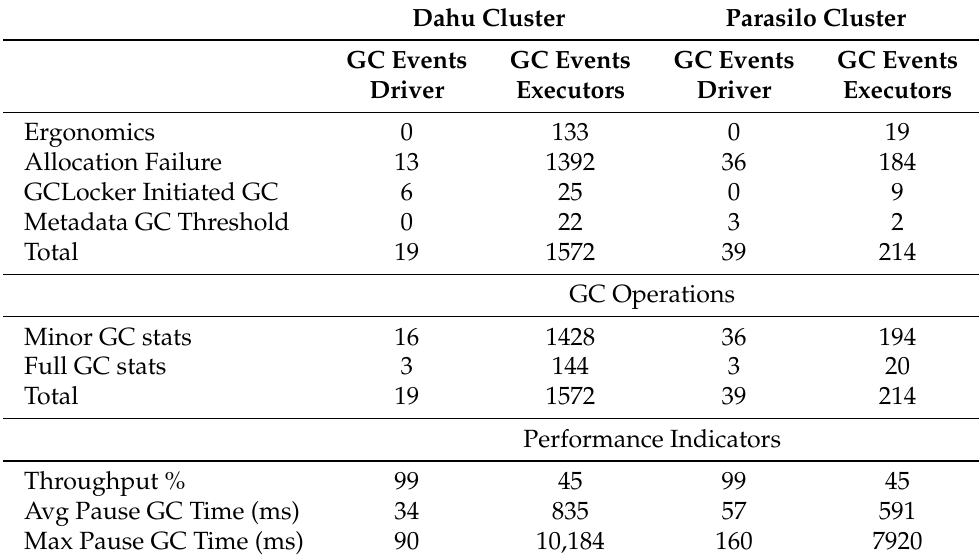
Table 9. GC Statistics for Stateful SUMServer Application Without Backpressure—Pipeline 2.